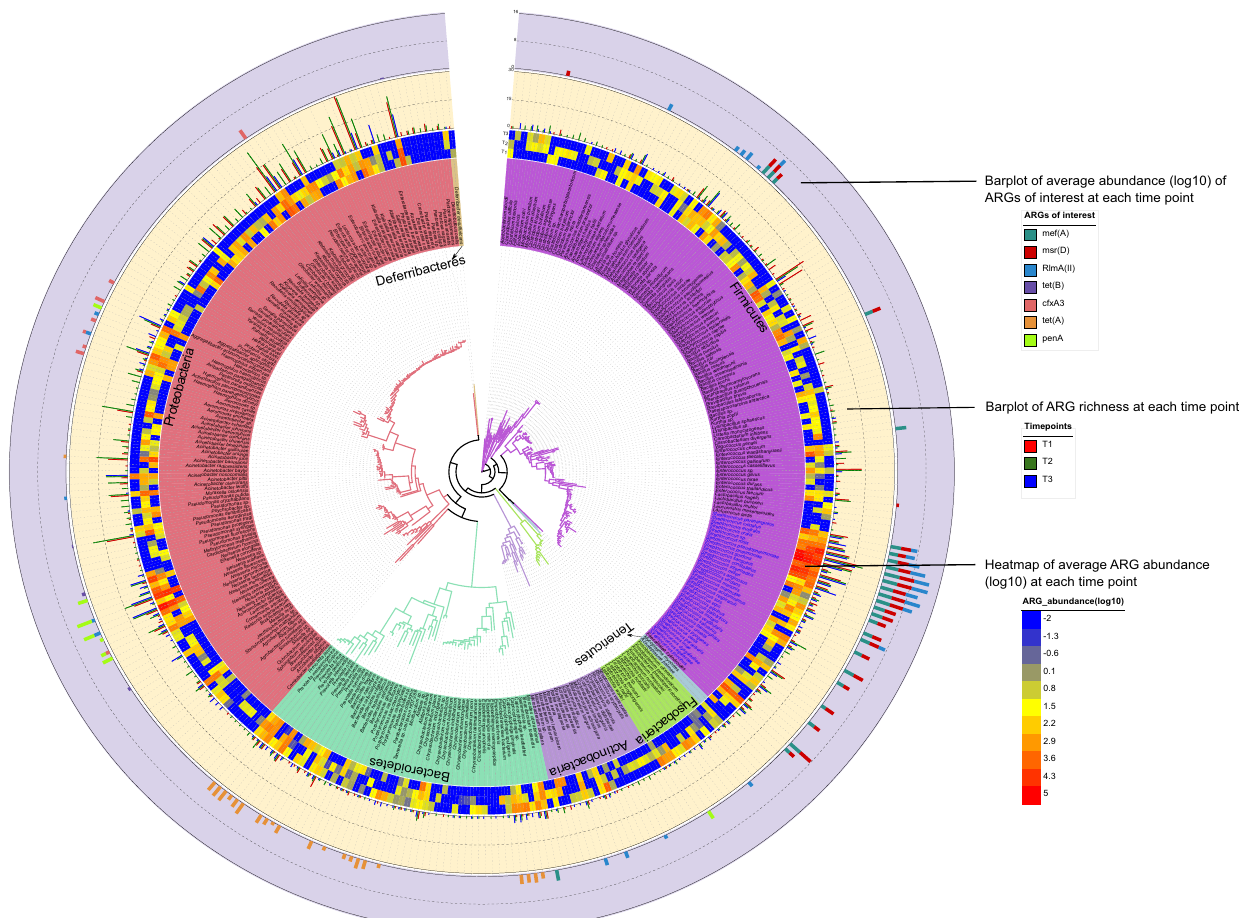
Fig. 4 | Phylogenetic tree of ARG-carrying species. A total of 356 ARG-carrying species across all time points were identi fi ed and used to reconstruct a species tree using 16S rRNA sequences. The tree was generated using RAxML v8.0.0 and annotated using The Interactive Tree Of Life v6. Strains belonging to the same specieswere collapsedforabundance calculation.Speciesfromthe Streptococcus genus are highlighted in blue font. From inner to outer layer, presented per